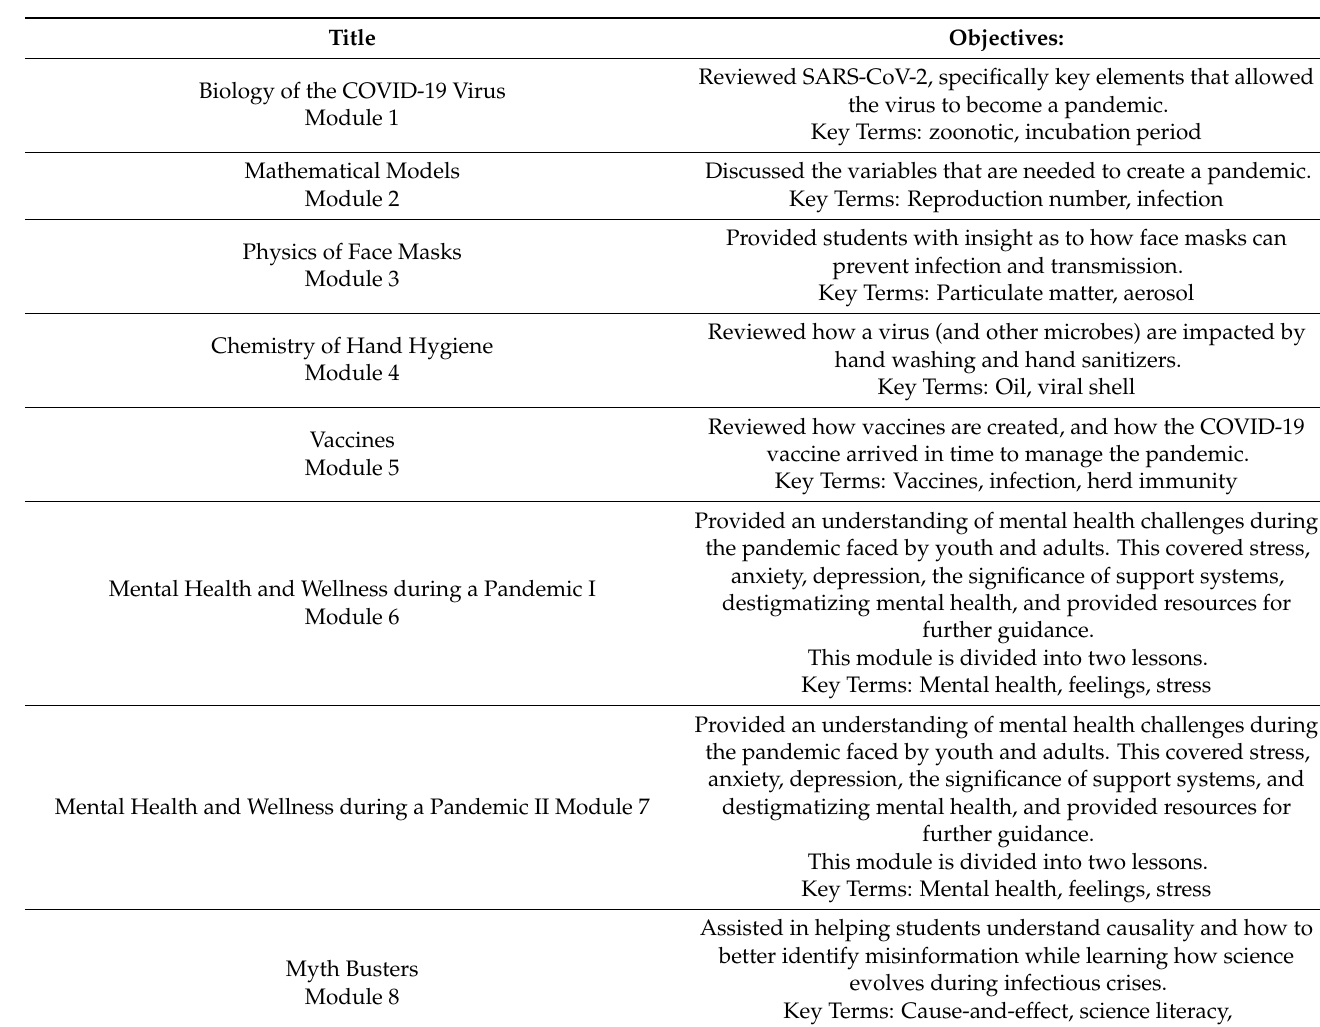
Table 1. List of COVID-19 Curriculum